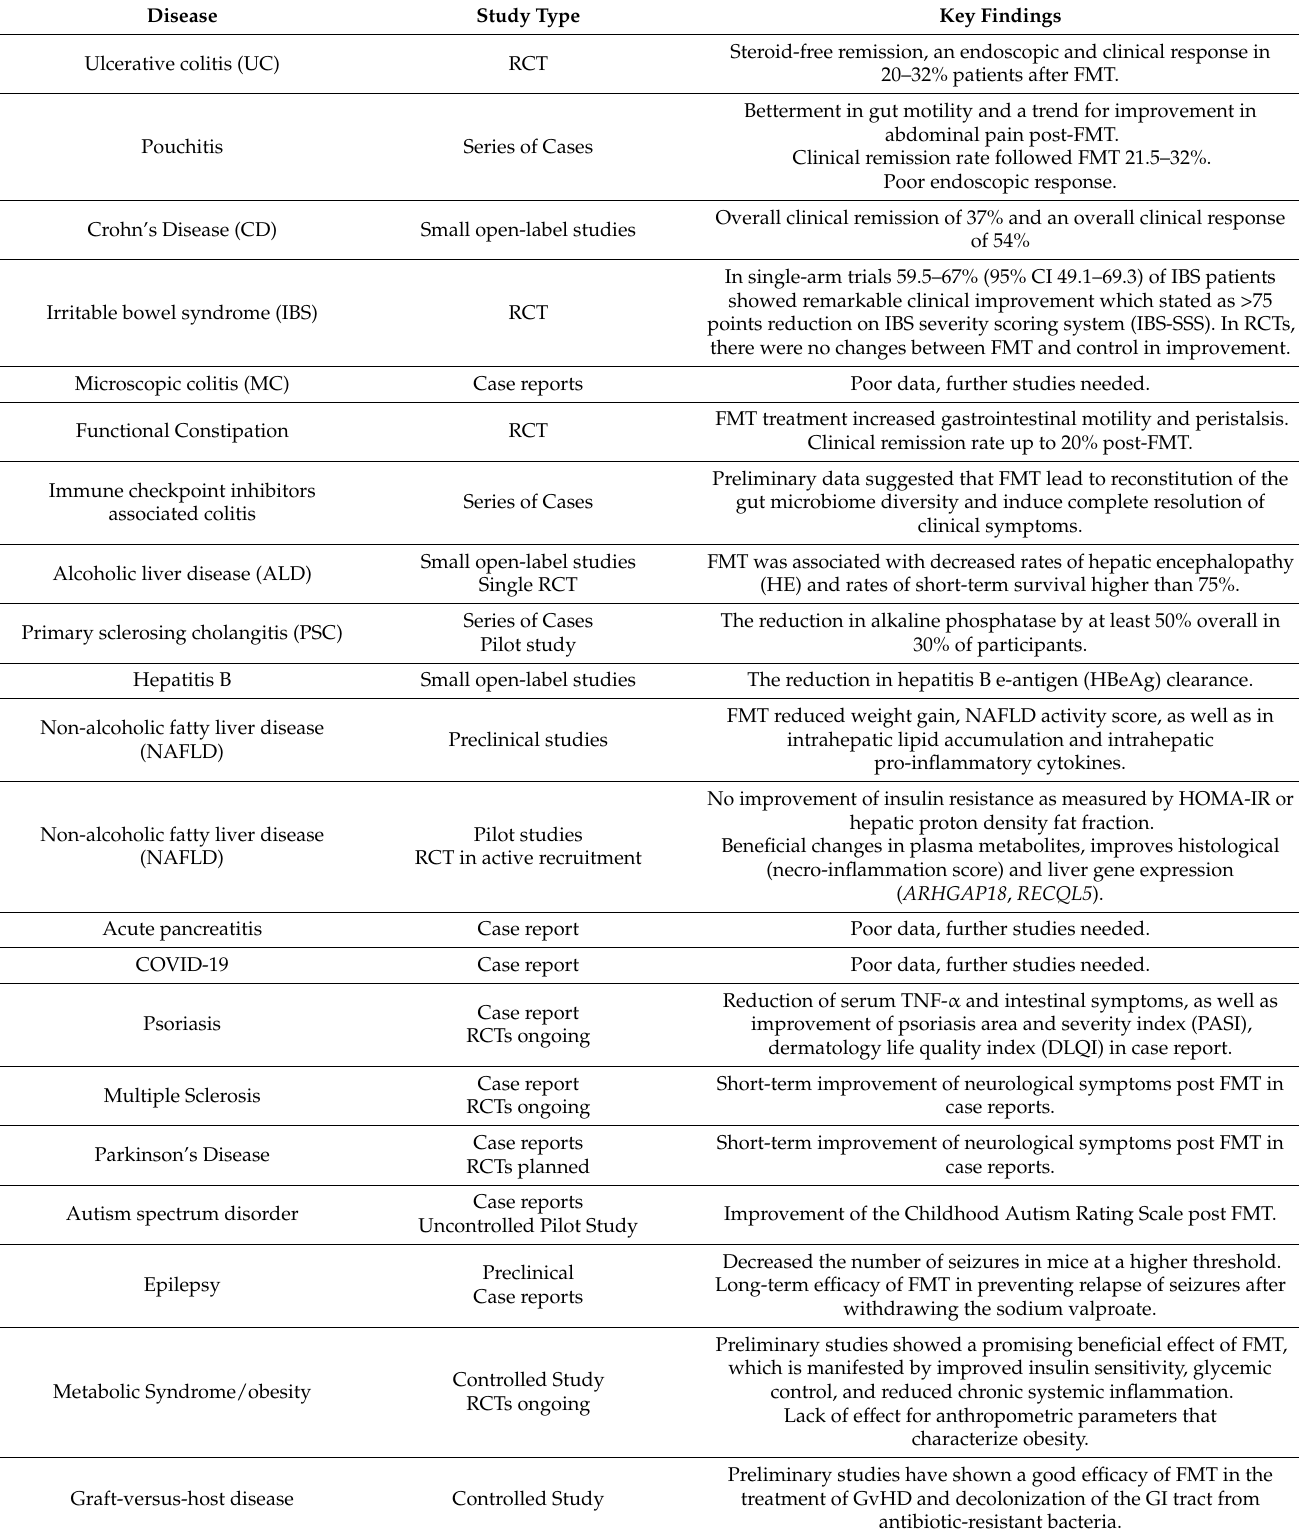
Table 1. Diseases for which the effectiveness of FMT is being